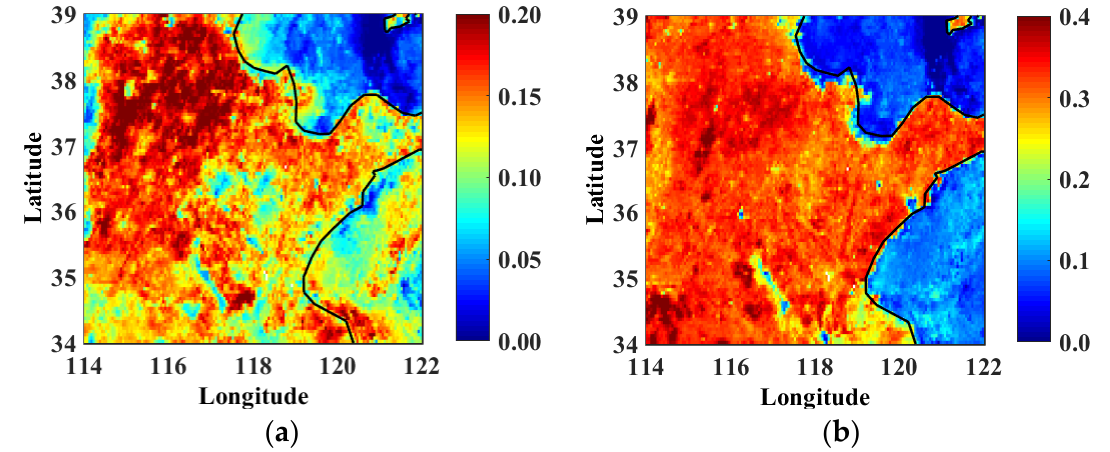
Figure 9. MODIS 16-day composite reflectance normalized to 0 degrees on 1 July 2019; ( a ) red band and ( b ) near-infrared band.